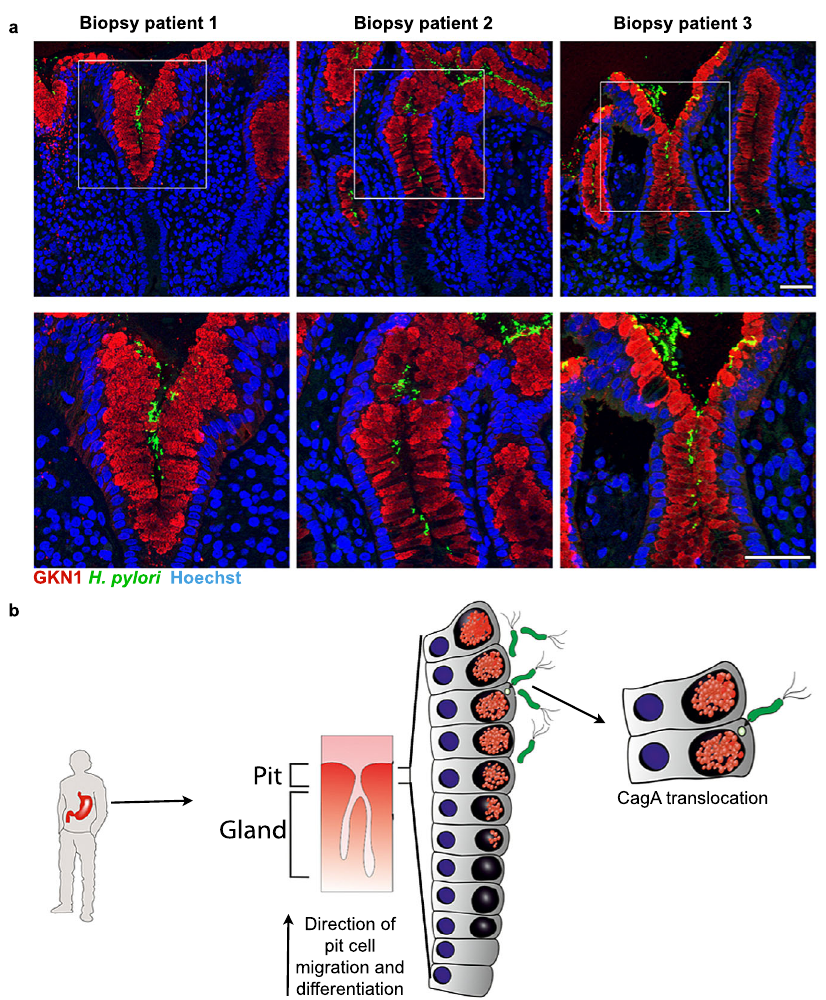
Fig.6| H.pylori colocalizeswithdifferentiatedpitcellsinvivo.a Representative confocal microscopy images of H. pylori -positive tissue sections co-stained for GKN1 (red) and H. pylori (green). Nuclei were counterstained using Hoechst 33342